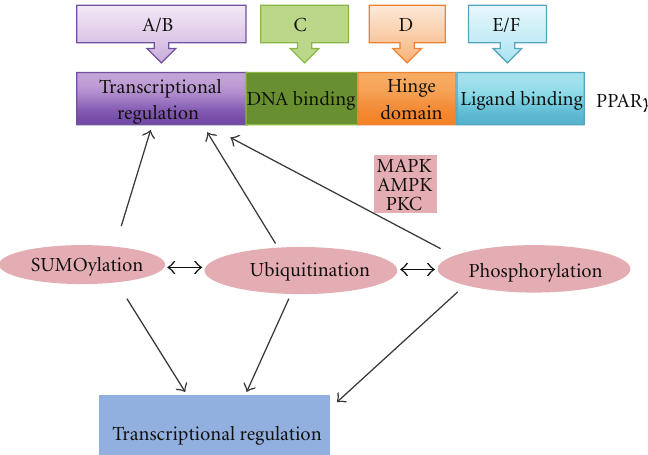
Figure 1: A schematic representation of the PPAR γ molecule and its domains with their function. The molecule of PPAR γ consists of an aminoterminal domain (also called A/B domain), which is responsible for ligand-independent transcriptional regulation. The following domain (also called domain C) contains two zinc finger-like and α -helical DNA-binding motifs typical of transcription factors. The C domain interacts with DNA through a PPRE (Peroxisome Proliferator Response Element) sequence. More carboxy terminal is the hinge domain (or D domain) which allows independent movement of the next and last domain of PPAR γ molecule, domain E/F. This is the ligand-binding domain and potentiates the ability of PPAR γ to dimerize with RXR α and recruit coactivators for transcription. Several post-translational modifications such as phosphorylation, ubiquitination, and SUMOylation modulate PPAR γ